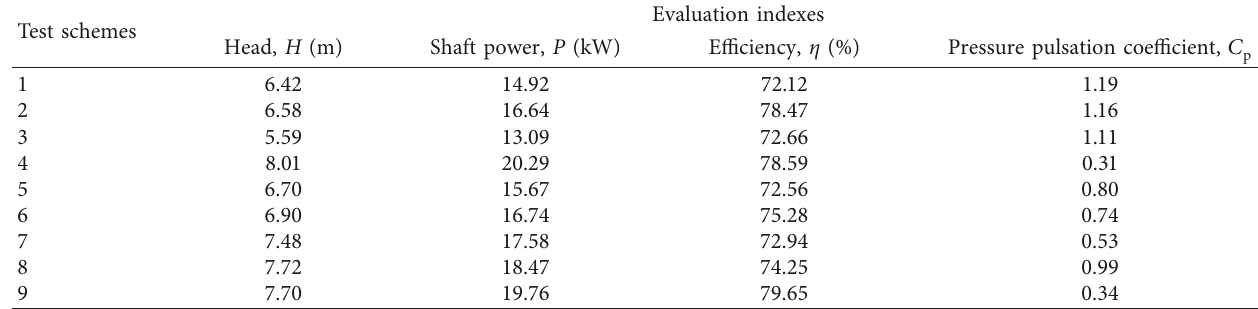
Table 5: Results of the nine test schemes.